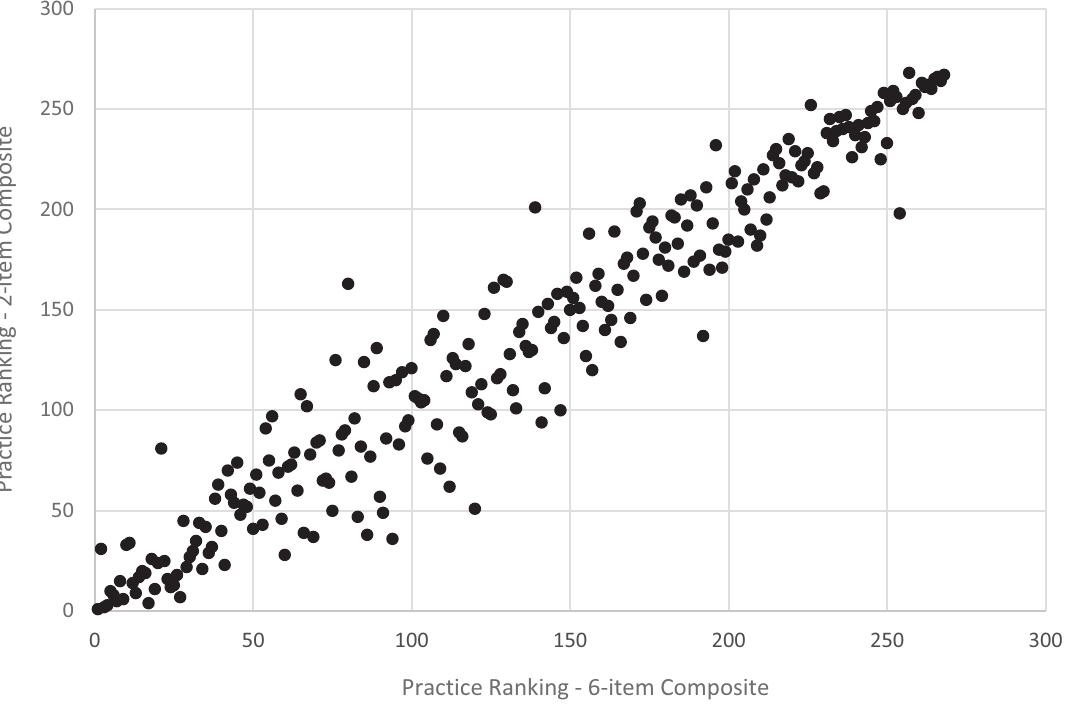
Figure 4. Practice ranking, revised vs . original adult communication composite, CAHPS PCMH 2013 ( n = 268 practices).